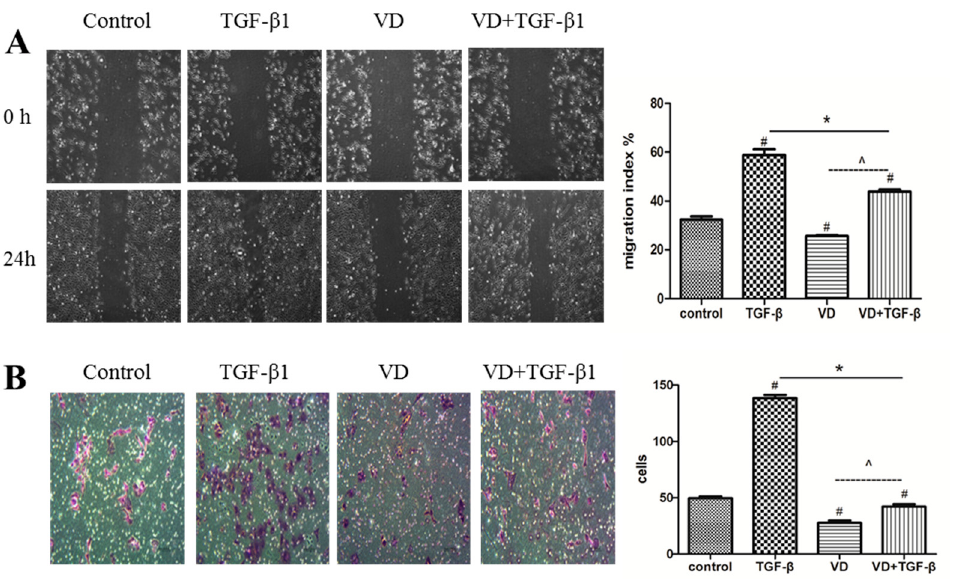
Figure 3. 1 α ,25(OH) 2 D 3 inhibited the migration and invasion of SKOV-3 cells during TGF- β 1-induced EMT. ( A ) Left : representative pictures of the wound area obtained 24 h after scratching. 100× magnification; Right : migration index (%) = [(the initialized width of the scratch) − (the final width of the scratch)]/(the initialized width of the scratch); ( B ) Left : invasion assay was carried out using the 24-well Becton Dickinson (BD) Biocoat Matrigel Invasion Chambers(magnification of 400×); Right : the cells on the bottom of inserts were counted under microscope. # p < 0.05 versus negative control, * p < 0.05 versus TGF- β 1, and ^ p < 0.05, 1 α ,25(OH) 2 D 3 (VD) + TGF- β group versus VD group.